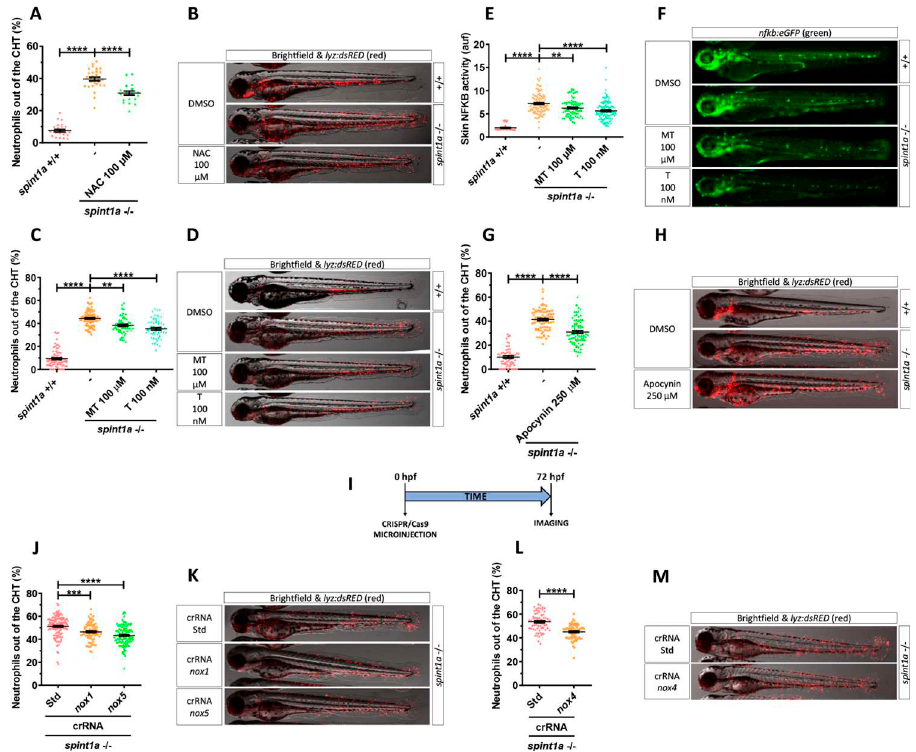
Fig 3. NADPH oxidase–derived ROS promote skin inflammation in Spint1a-deficient larvae. Quantification of neutrophil dispersion out of CHT of wild-type and Spint1a-deficient embryos treated with 100 μ M NAC (A) , 100 μ M mito-TEMPO (MT) and 100 nM tempol (T) (C) , 250 μ M apocynin (G) , or upon genetic inactivation of nox1 and nox5 (I, J) and nox4 (I, M) with CRISPR/Cas-9. Representative merge images (brightfield and red channels) of lyz : dsRED zebrafish larvae of every group are shown (B, D, F, H, K, M) . Determination of NFKB transcriptional activity in the skin of embryos treated with MT and T (E) and representative images (green channel) of nfkb : eGFP zebrafish larvae of every group (F) . Each dot represents one individual, and the mean ± SEM for each group is also shown. p -Values were calculated using 1-way ANOVA and Tukey multiple range test and t test. ns, not significant, �� p � 0.01, ���� p � 0.0001. The data underlying this figure can be found in S1 Data. ANOVA, analysis of variance; CHT, caudal hematopoietic tissue; NAC, N-acetylcysteine; ROS, reactive oxygen species.